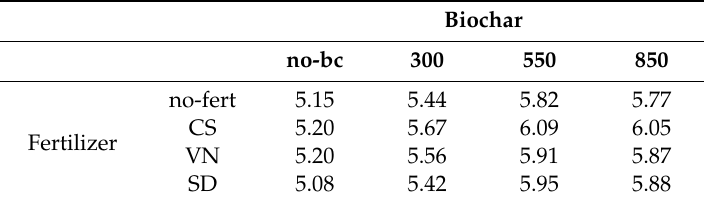
Table 5. Final pH KCl for the di ff erent treatment level combinations.